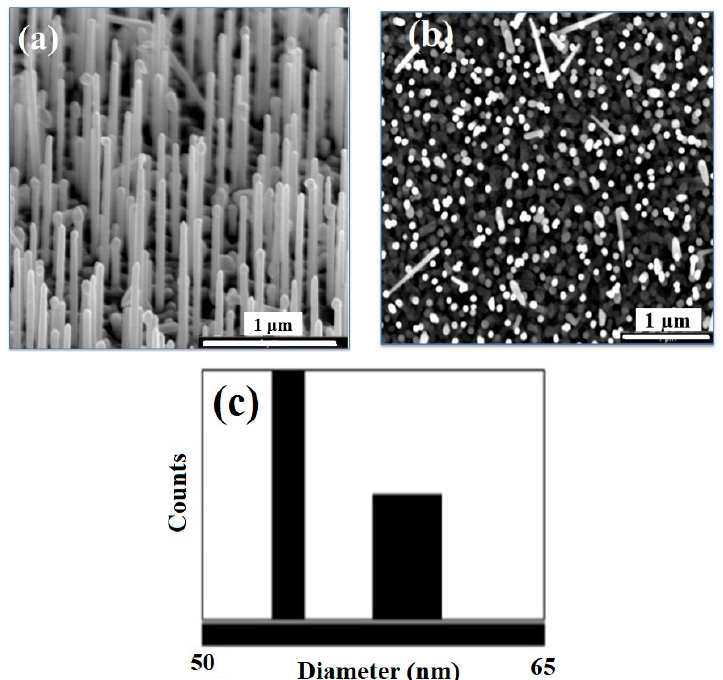
Figure 4. ( a ) 40° tilted view SEM image of perpendicular ZnO NWs arrays grown on ZnO SL/Si (100) substrates at 5 mTorr, ( b ) top view SEM image of the as-grown ZnO NWs, ( c ) corresponding size